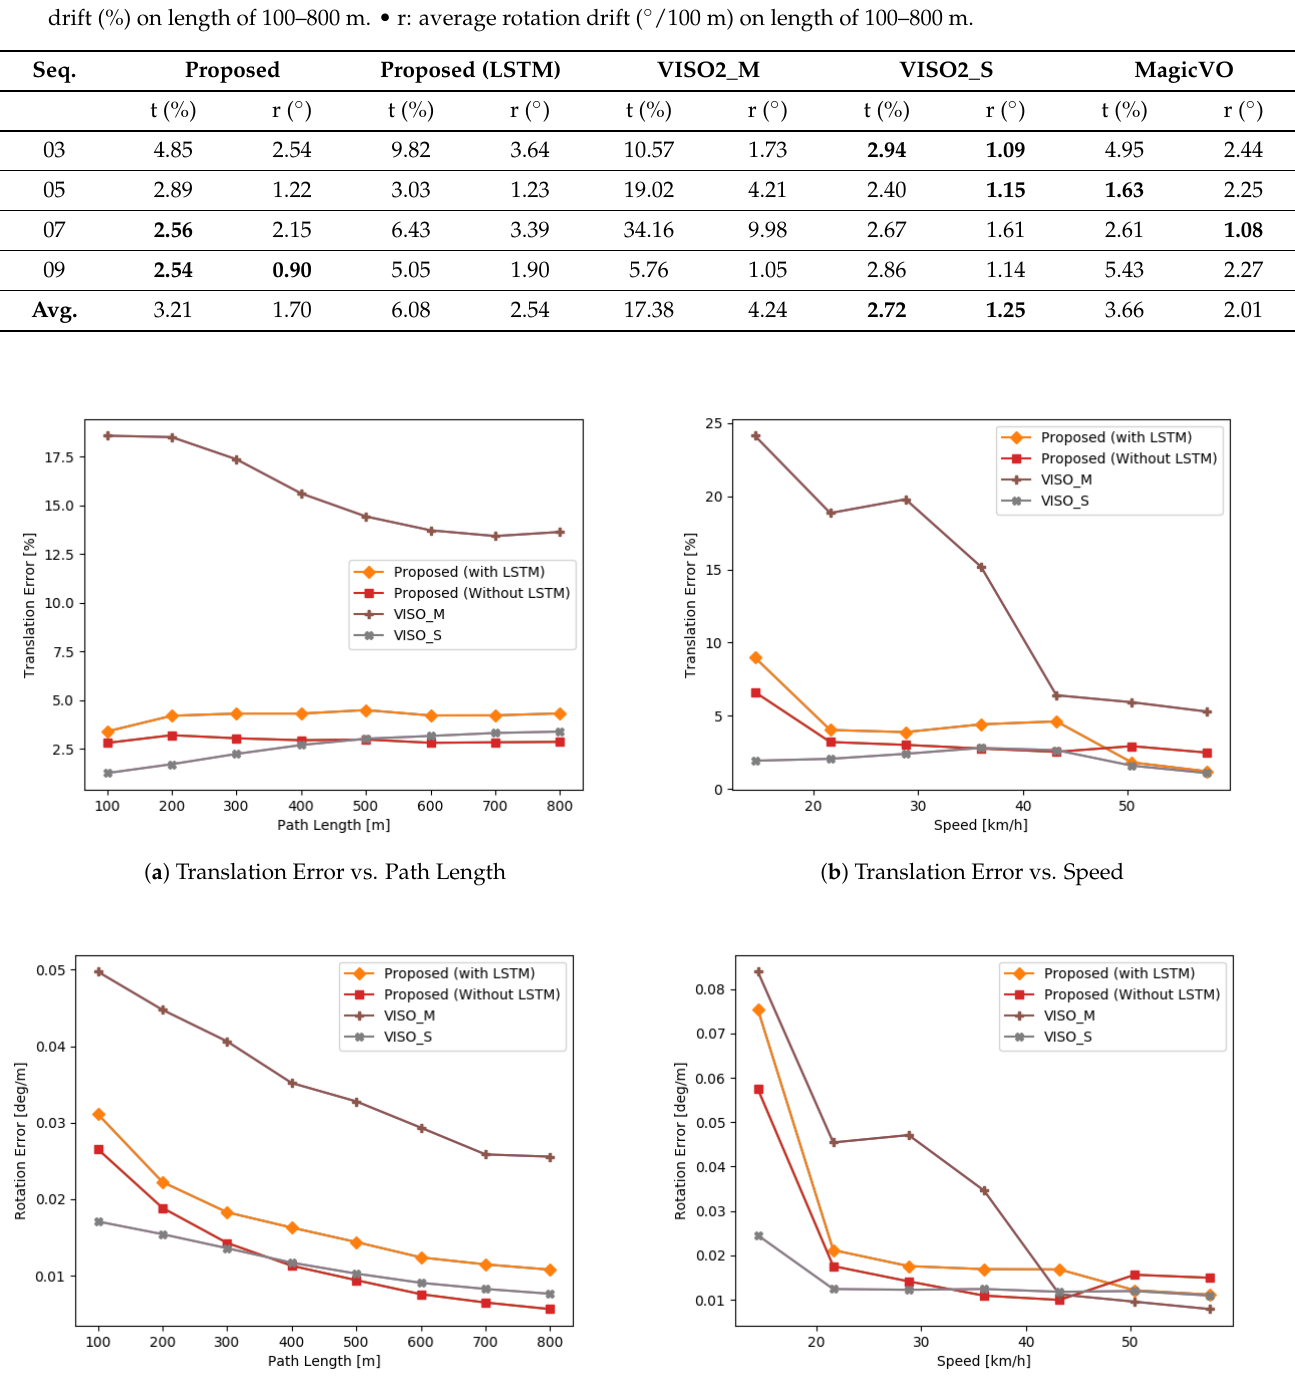
Figure 4. Comparison of the proposed method based on the KITTI evaluation